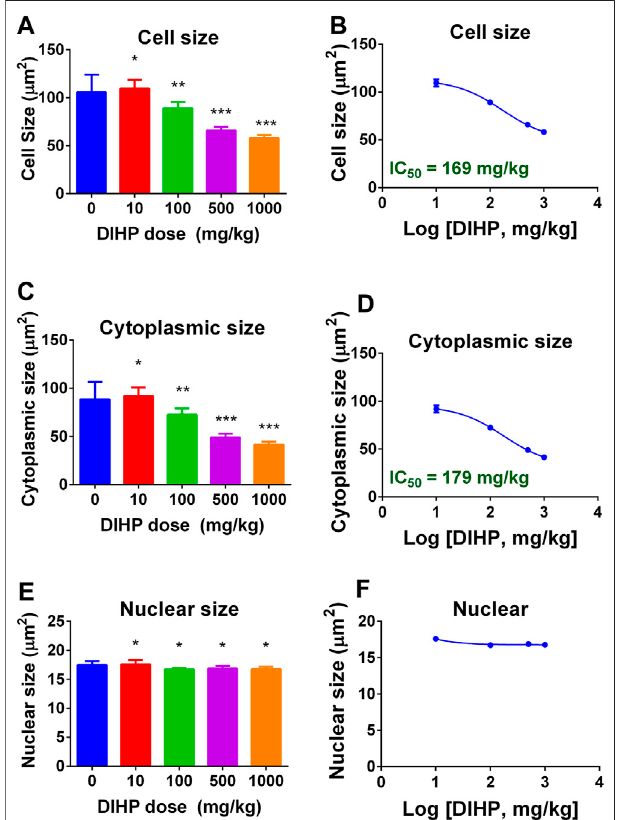
FIGURE 2 | Effect of DIHP exposure on fetal Leydig cell (FLC) cell, cytoplasm, and nuclear size. From GD12 to GD21, the dams were gavaged with0(control),10,100,500,and1,000 mg/kgDIHP.Thedataareexpressed as mean ± SEM. Panels (A, B) : cell size; Panels (C, D) : cytoplasm size; Groups (E, F) : nuclear size; Groups B, D, and F: IC 50 values. Data are expressed as mean ± SEM, n (cid:1) 6; * p > 0.05, ** p < 0.05, *** p < 0.01 indicate that the signi fi cant level between the DIHP group and the control group,